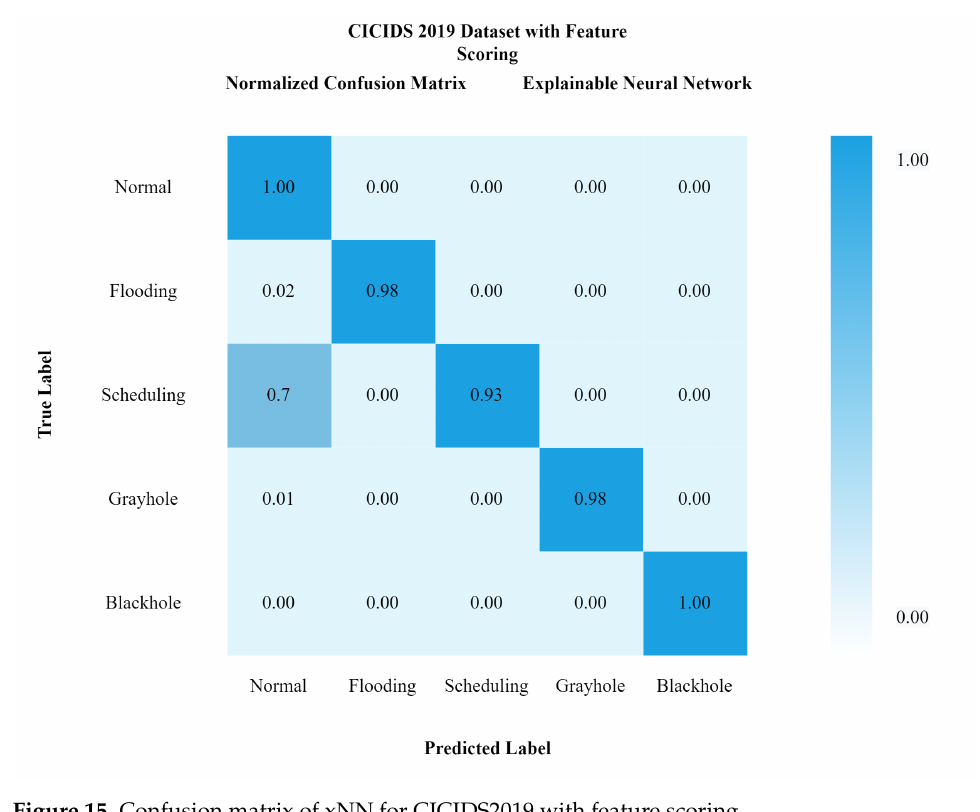
Figure 15. Confusion matrix of xNN for CICIDS2019 with feature scoring.